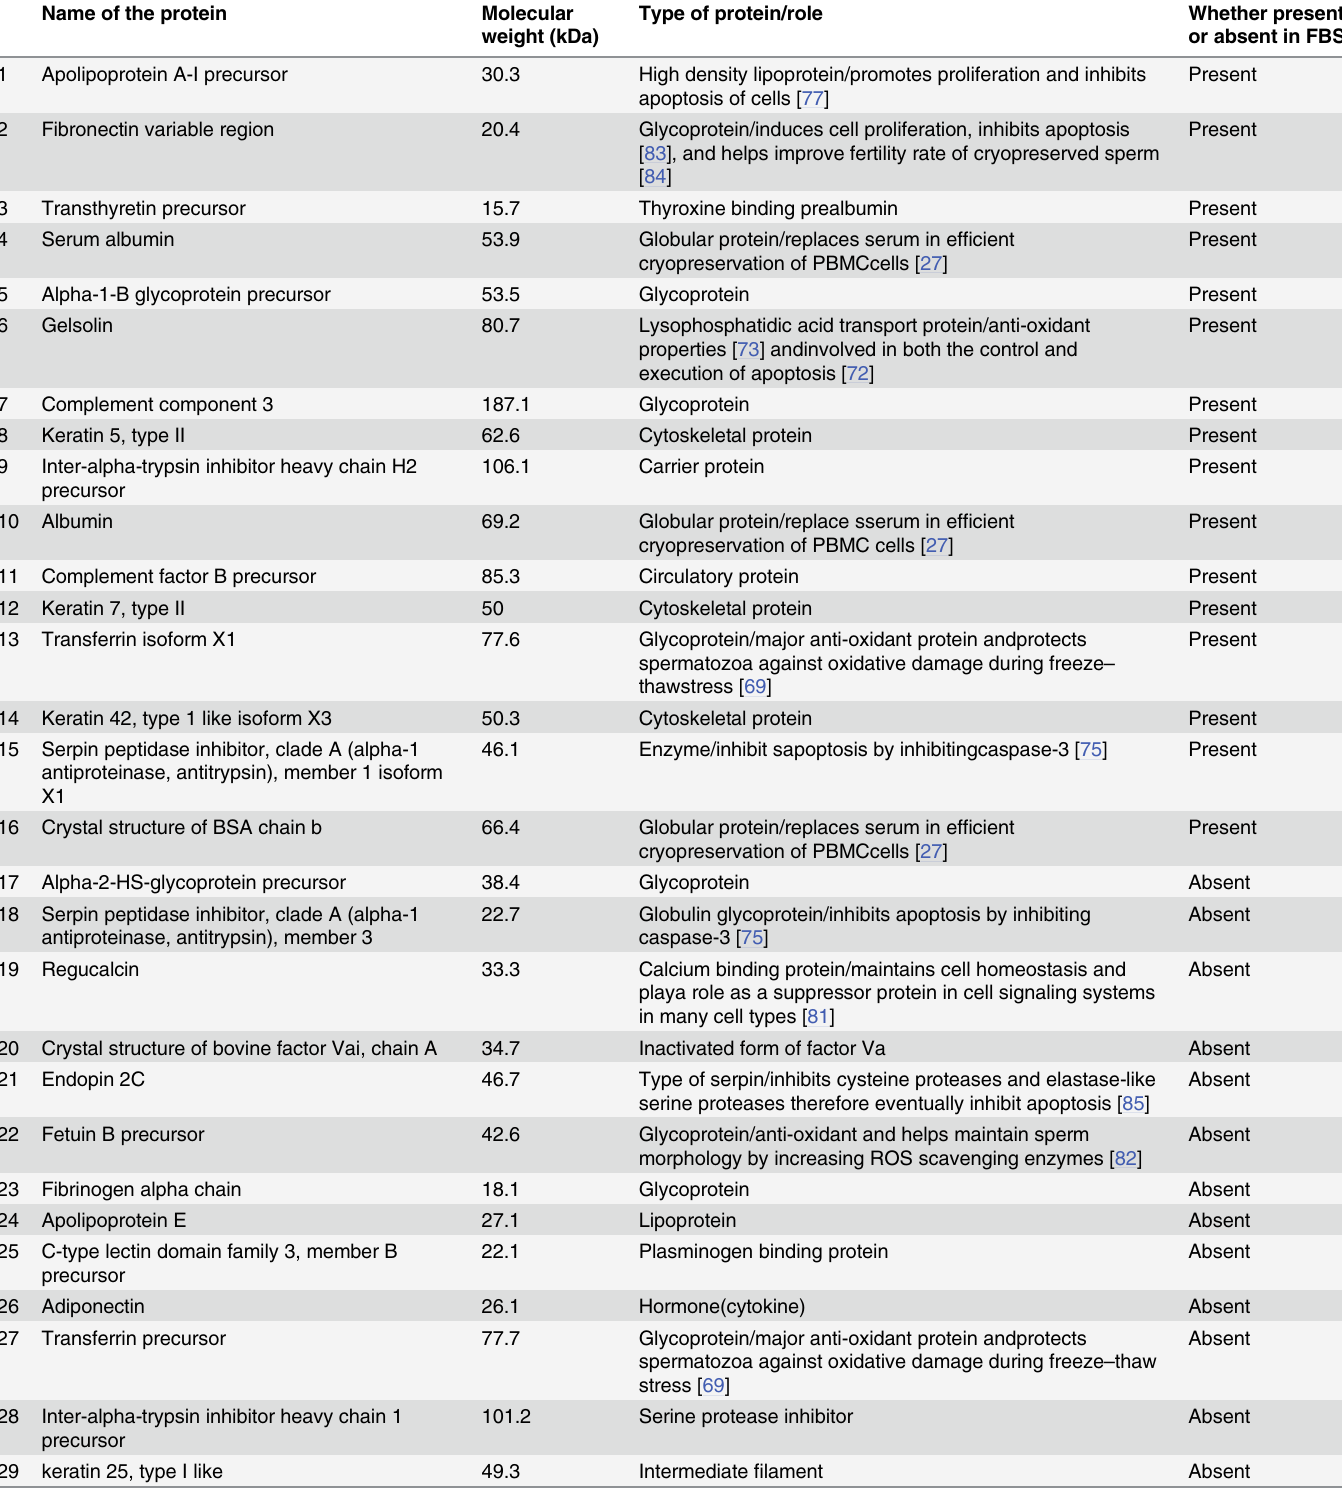
Table 2. Proteomic analysis of BuOF and comparison with